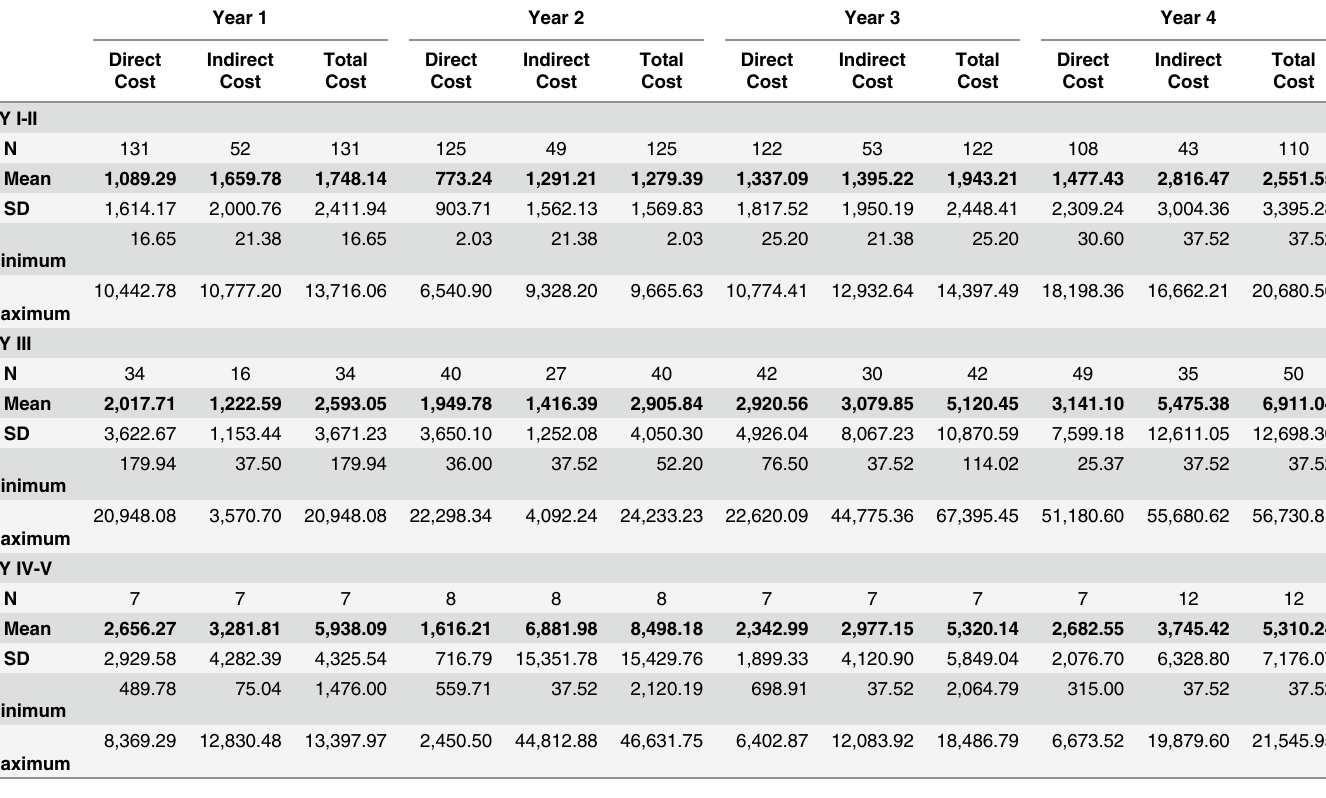
Table 3. Description of Parkinson ’ s disease costs during the four years of study by disease